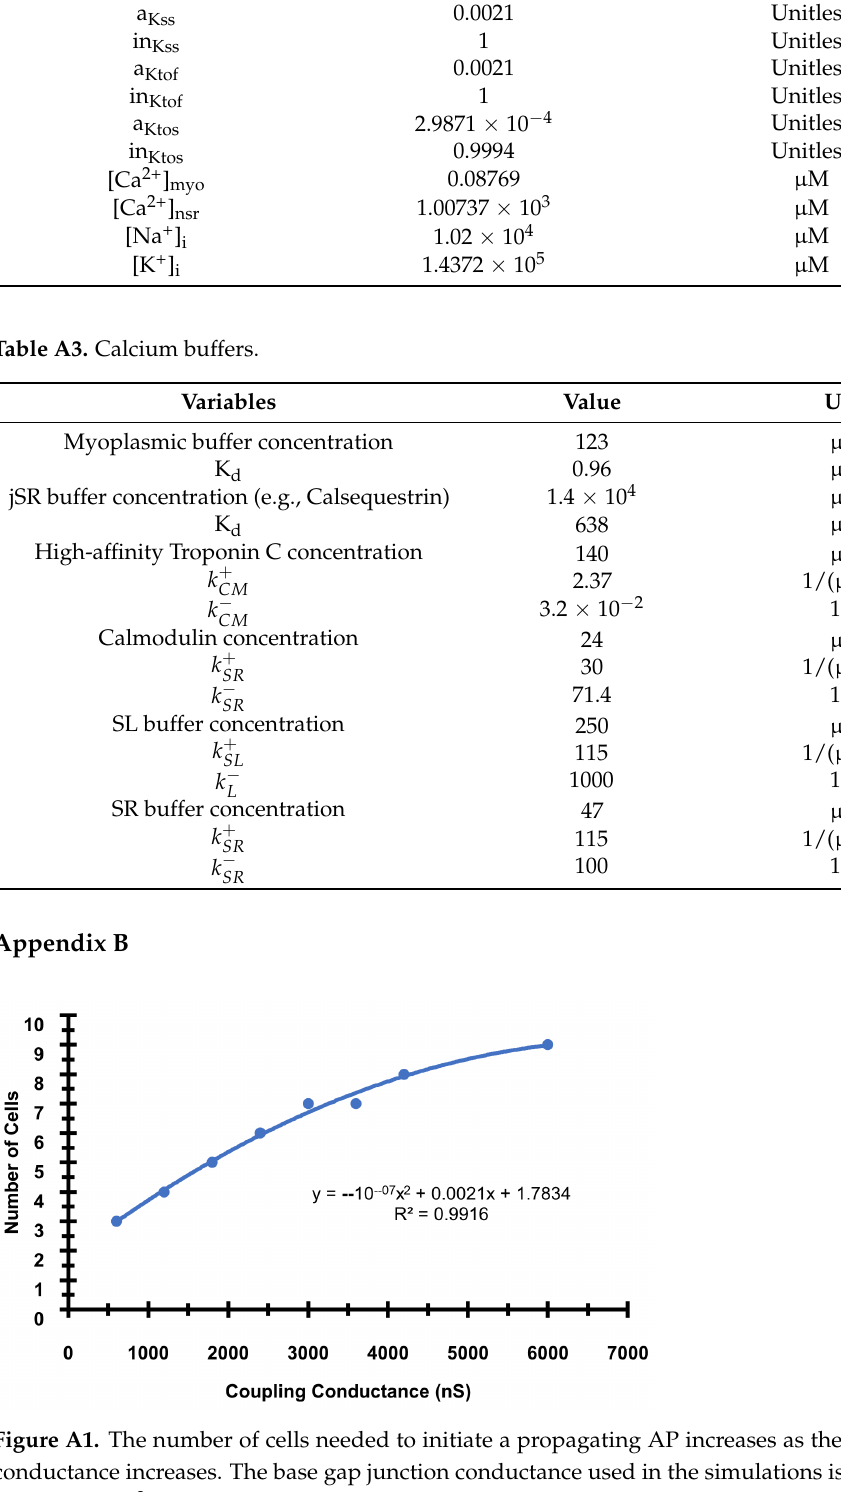
Figure A2. 1-D Simulation with 5 cells fail to produce an action potential that can propagate between cells. Cell numbers 50, 100, 150, and 200 overlap.